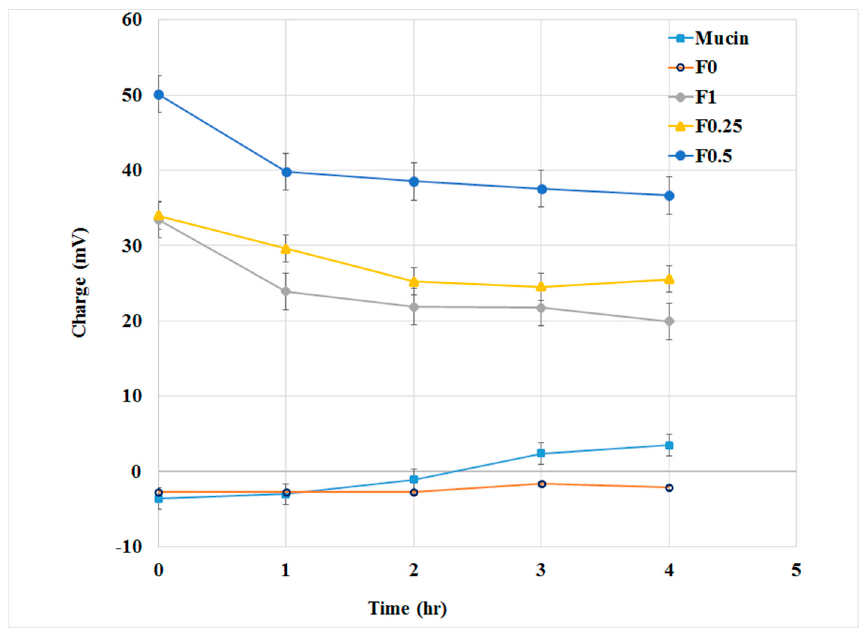
Figure 4. Assessment of the zeta potential (ZP) of the PLGA and LMWC-PLGA NPs throughout incubation in the aqueous dispersion of mucin.